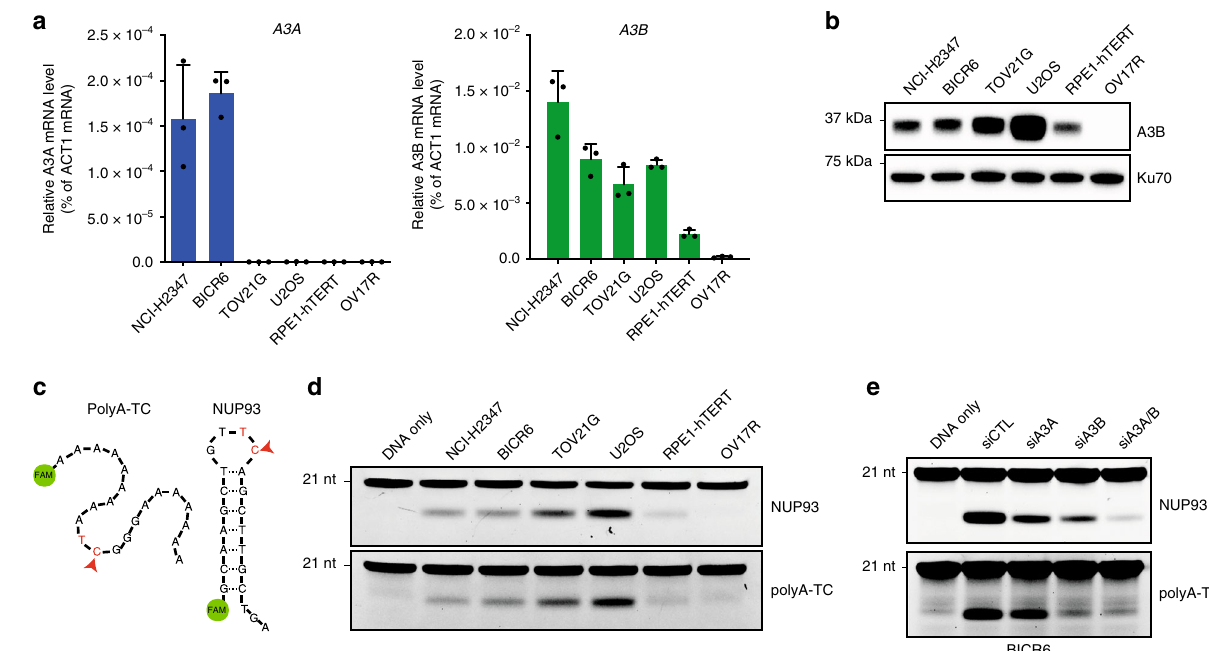
Fig. 2 APOBEC3A expression does not correlate with APOBEC activity monitored by DNA deaminase activity assay. a Analysis of A3A and A3B mRNA expression in a panel of cancer cell lines determined by RT-qPCR. Error bar: S.D. ( n = 3). b A3B levels in the indicated cancer cell lines were analyzed by western Blotting. c Schematic representation of DNA oligonucleotides used in this study. polyA-TC: oligonucleotide without any secondary structure (single-stranded DNA). NUP93: natural occurring DNA hairpin in the gene NUP93 . d Deamination activity on PolyA-TC and NUP93 substrates from indicated cell extracts (30 μ g). e A3A and/or A3B knockdown in BICR6 cells. Deamination activity in BICR6 cell extracts (30 μ g) was monitor after indicated knockdown on both PolyA-TC and NUP93 substrates. Source data are provided as a Source Data fi